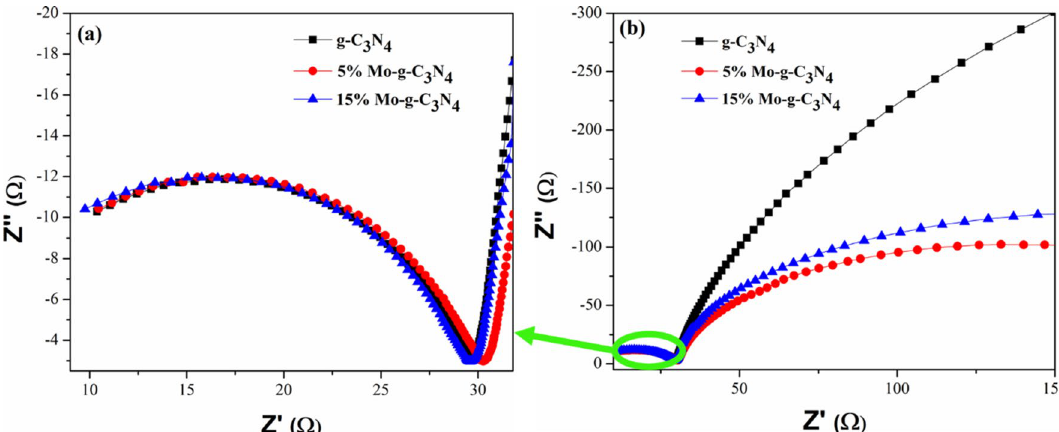
Figure 8. EIS studies of as prepared g-C 3 N 4 Nanotubes and Mo-Impregnated g-C 3 N 4 Nanotubes Photocatalyst ( a ) Magnified view at the high frequency of 5% Mo- g-C 3 N 4 nanotubes presenting lowest charge transfer resistance ( b ) The semicircle of % Mo- g-C 3 N 4 is at a lower position in the Nyquist plot as compared to 15% Mo- g-C 3 N 4 and g-C 3 N 4 at low